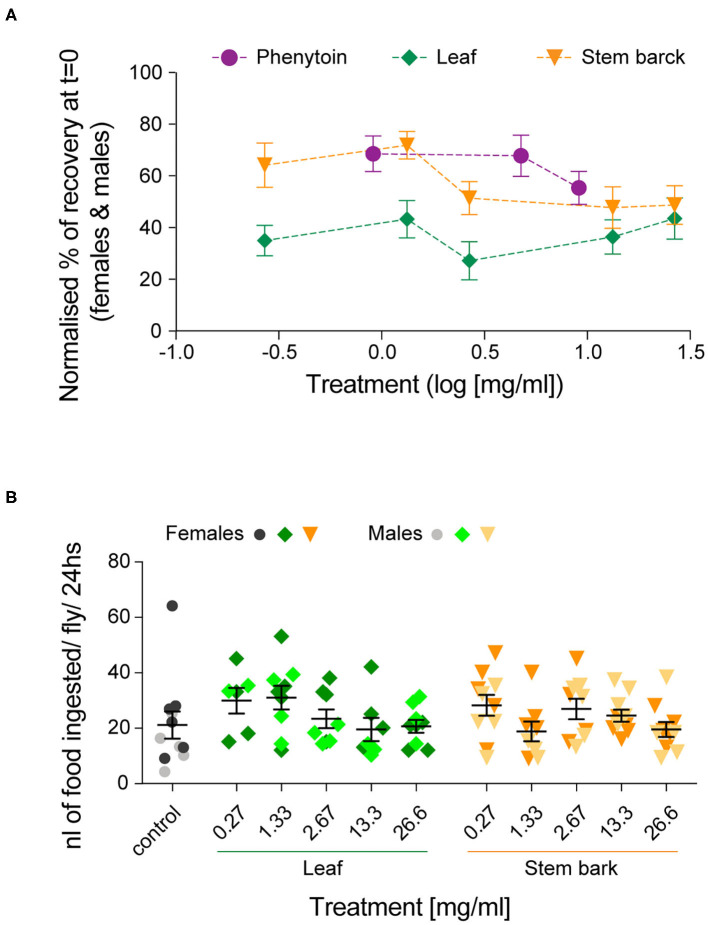
Dose-dependent prophylactic effect of phenytoin and, leaf and stem bark A. senegalensis extracts. (A) Normalized % of recovery at t = 0 for females and males. The concentration is in log10 scale. An ANOVA comparing the effect of the three drugs treatment was significant [F(2,199) = 15.06, p < 0.0001, η2 = 0.13]. A post hoc Bonferroni multiple comparisons test was used to test for differences between the drugs (phenytoin vs. leaf p < 0.0001; vs. stem p = 0.35 and leaf vs. stem p = 0.0001). No significant differences between concentrations of each drug were found, apart when comparing with the control (Tukey's multiple comparisons test). (B) Amount of food ingested per fly and per 24 h. A two way ANOVA showed no effect of drug [F(1,103) = 0.03, p = 0.86], no effect of concentration [F(5,103) = 1.63, p = 0.16] and no interaction [F(5,103) = 1.26, p = 0.28]. A post hoc Dunnett's multiple comparisons test comparing the control with each treatment did not yield any significant differences.